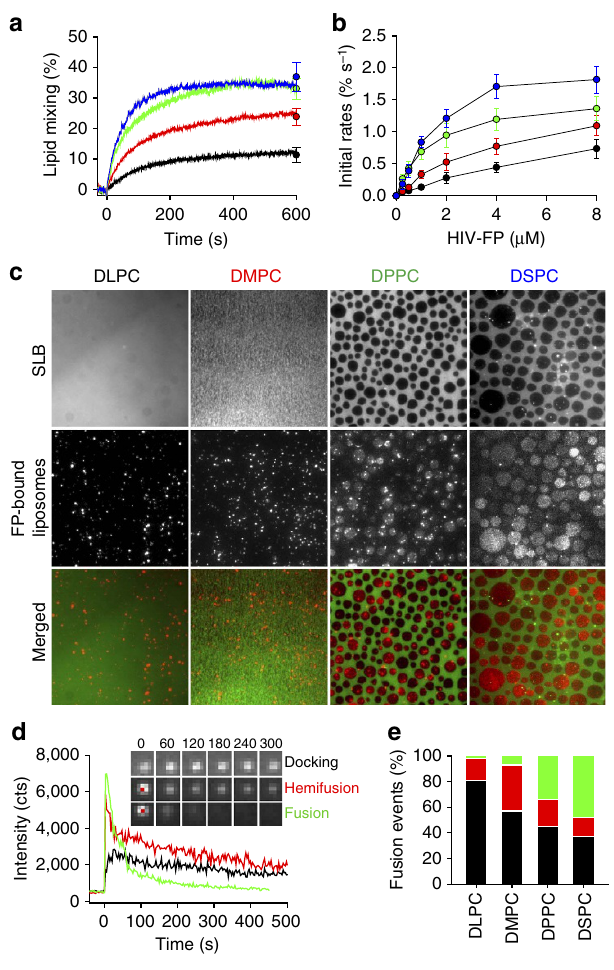
Figure 5 | Effect of hydrophobic mismatch on Lo domain formation and membrane fusion. ( a ) Effect of saturated lipid component on lipid mixing. 1 m M HIV-FP was added to 50 m M LUVs composed of DSPC/DOPC/DOPS/ Ch (2:1:1:1; blue), DPPC/DOPC/DOPS/Ch (2:1:1:1; green), DMPC/DOPC/ DOPS/Ch (2:1:1:1; red) and DLPC/DOPC/DOPS/Ch (2:1:1:1; black). ( b ) Initial rates of lipid mixing as function of HIV-FP concentration. Same colour designations are used as in a . Data are mean ± s.d. from three experiments. ( c ) Fusion between LUVs and SLB. LUVs and SLBs were composed of saturated lipid/DOPC/DOPS/Ch (2:1:1:1). The saturated lipids are DLPC, DMPC, DPPC or DSPC as indicated. LUVs were added to SLBs which were pre-incubated with 5 m M HIV-FP for 10min. The images were acquired 20min after vesicle addition. Fluorescence micrographs of SLBs labelled with 0.1mol% Rh-PE (top row), TIRF micrographs of bound/fused LUVs labelled with 0.5mol% DiD on SLB (middle row), and merged images (bottom row). The scale of all images is 64 (cid:2) 64 m m 2 . ( d ) Representative single-LUV fusion events on SLBs including docking, hemifusion and full fusion. Time zero is defined as the first frame with a visible liposome. The insets show TIRF microscopy images of representative times (s) for each type of fusion event. The scale of all inset images is 2.5 (cid:2) 2.5 m m 2 . ( e ) Relative frequencies of single-LUV docking (black), hemifusion (red) and full fusion (green)